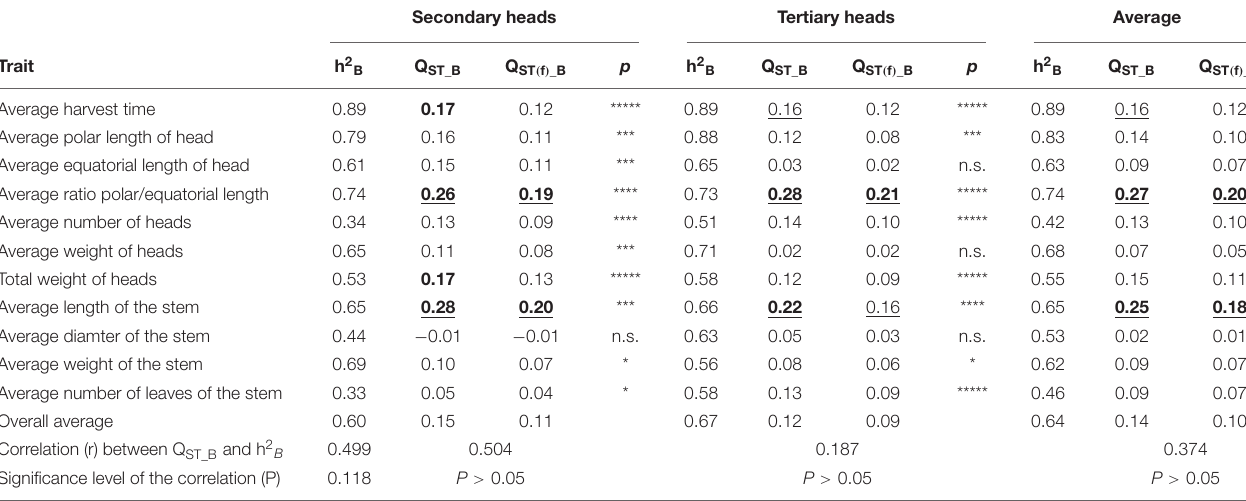
TABLE 4 | Nested Analysis of Variance (NANOVA) for the 11 traits measured at the stage of secondary and tertiary heads. Secondary heads Tertiary heads